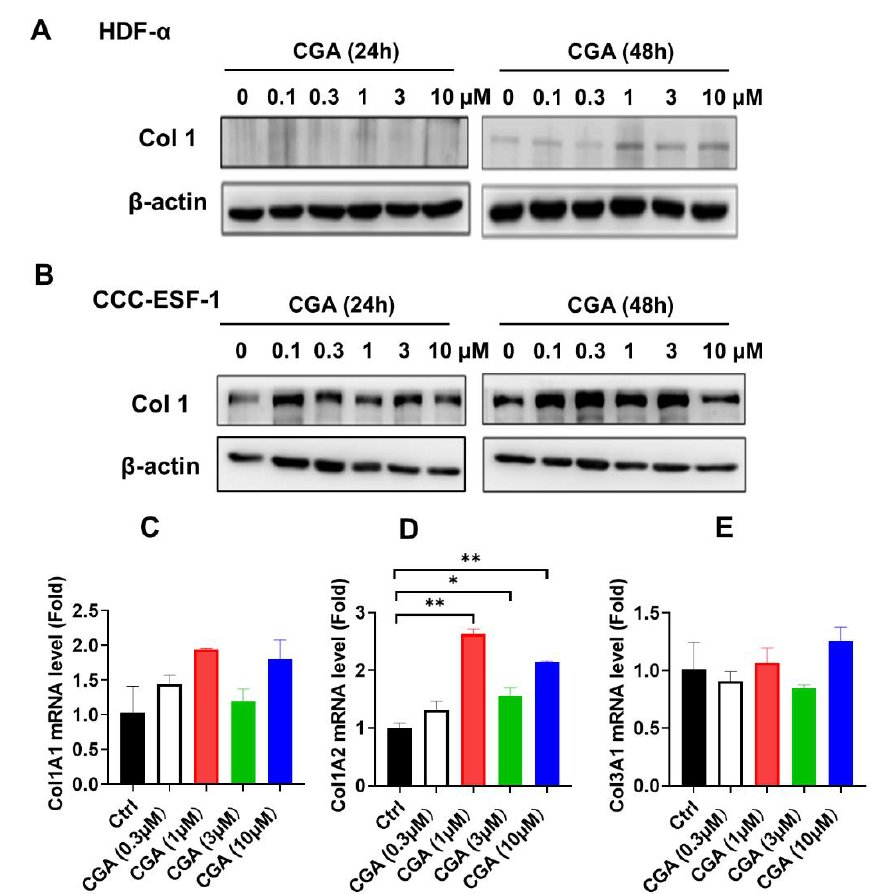
Figure 1. The effect of CGA on Collagen expression in human skin fibroblasts. The collagen I levels were detected by western blot assay after exposure of CGA for 24 or 48 h in HDF- α cells ( A ) and in CCC-ESF-1 cells ( B ). The Col1A1 ( C ), Col1A2 ( D ) and Col3A1 ( E ) mRNA levels were measured by qRT-PCR assay after treatment with CGA for 48 h in HDF- α cells. The values are expressed as the mean ± SD from three experiments. * p ≤ 0.05, ** p ≤ 0.01 indicate a significant difference.